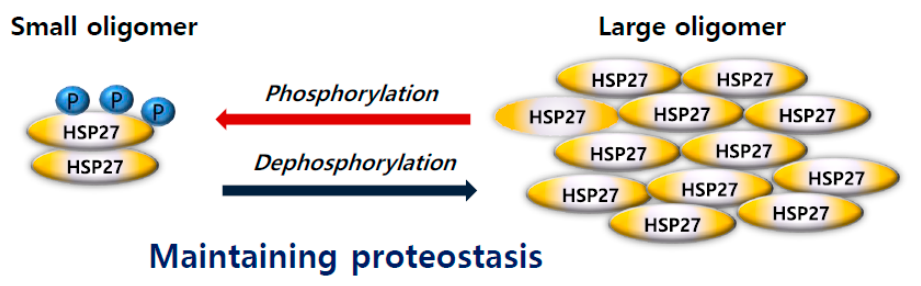
Figure 3. Phosphorylation induced conformational structural switching between different states. Heat shock protein 27 (HSP27) exists as large oligomers when unphosphorylated. At specific serine residues in the mitogen-activated protein kinase (MAPK) pathway, HSP27 switches to smaller oligomers. HSP27 conformational structure changes actively and contributes to maintaining proteostasis.